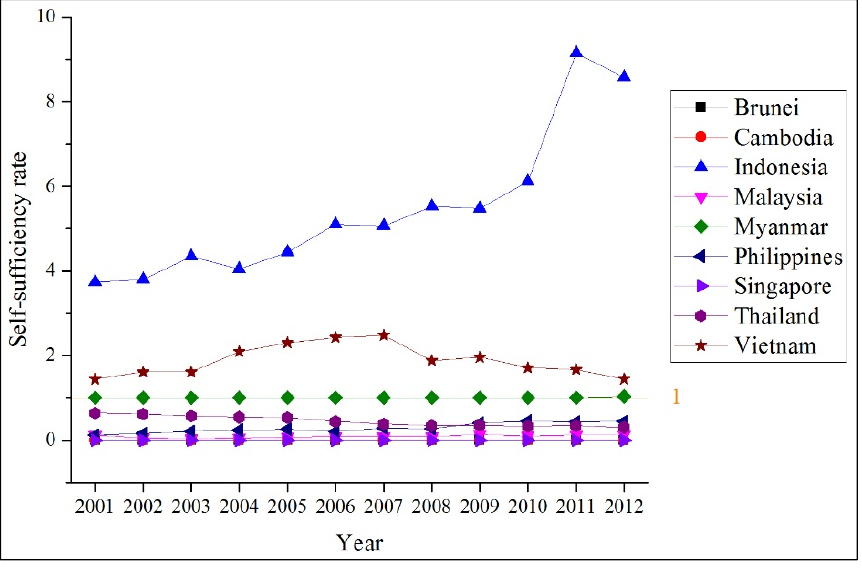
Figure 30. Coal self-sufficiency between 2001 and 2012.